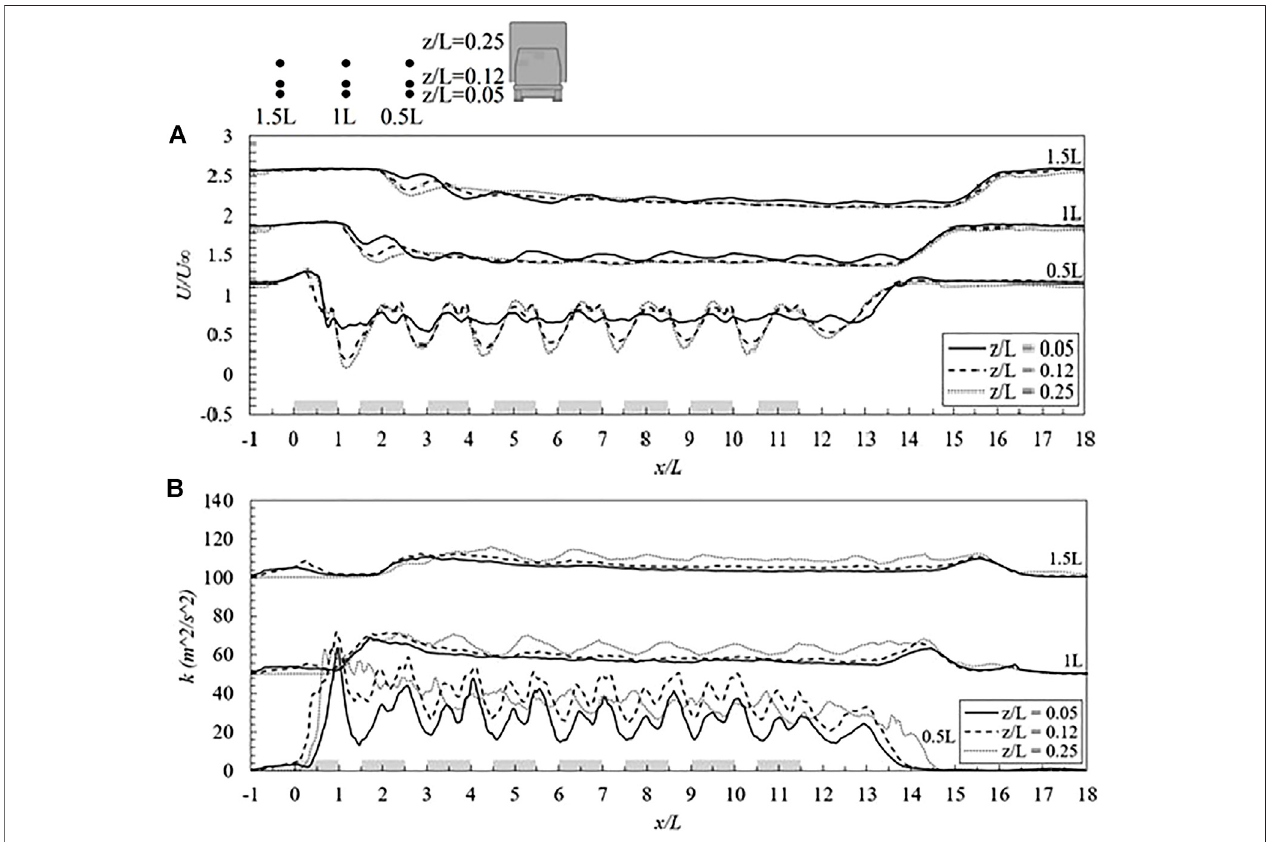
FIGURE8| Horizontalpro fi les atthehorizontaldistanceof0.5,1and 1.5 Lfrom theleesideofthelorriesatz/L =0.05,0.12and 0.25of (A) Velocitydistribution (B) Turbulent kinetic energy.